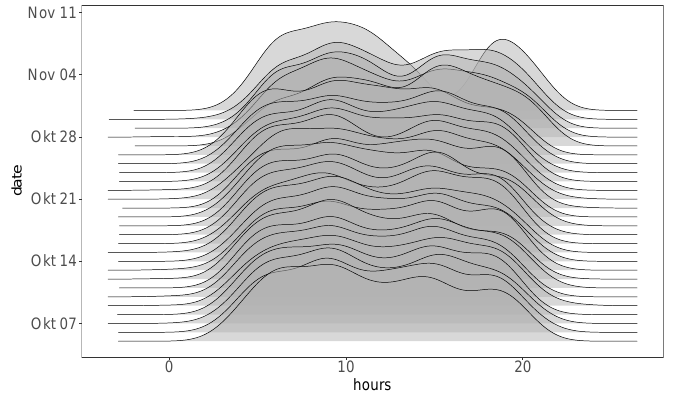
Figure 4. Traffic density of the day.